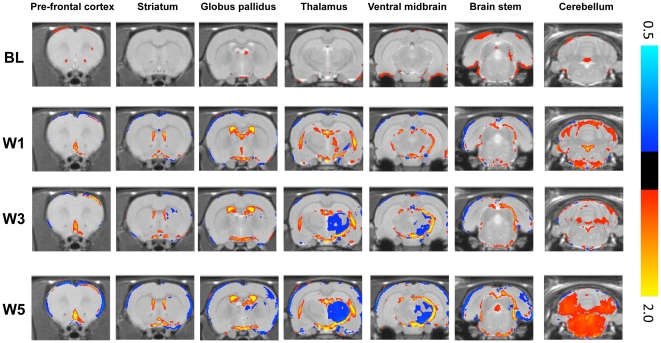
Deformation Based Morphometry confirms and extends manual segmentation analysis.Comparisons between the saline and lactacystin mean normalised MR images are shown for each time-point (p<0.02 uncorrected). The coloured overlay shows the scale factor of local apparent volume differences (on a logarithmic scale). Red/yellow indicates local tissue volume expansions, whilst blue/cyan indicates local tissue volume contractions.